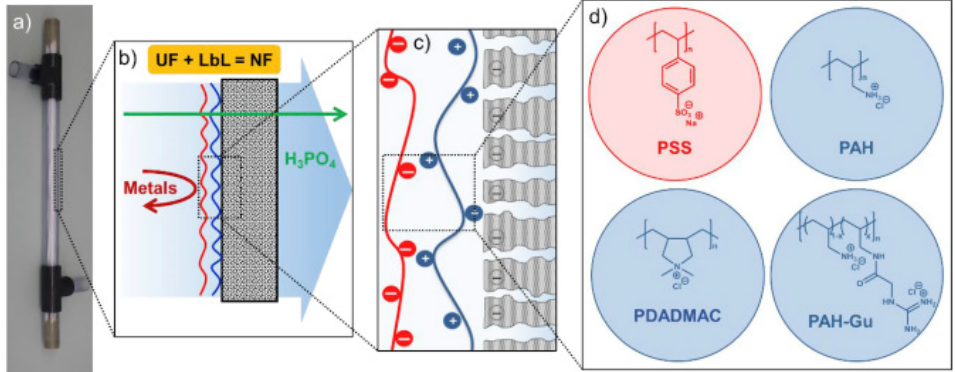
Figure 8. ( a ) Picture of a sulfonated sPES UF membrane from Pentair X-Flow, and schematic presentations of ( b ) alternately deposited PEs (only 2 PEs are given for matters of simplicity), including a summary of the separation properties, ( c ) a zoom-in of the interfaces inside the lumen, ( d ) molecular structures of the PES used in this study. Reprinted from [198], with permission from Elsevier.